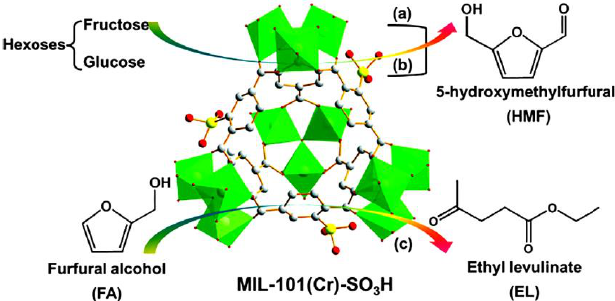
Figure 10. Transformations of ( a ) fructose and ( b ) glucose into HMF and ( c ) furfural alcohol into ethyl levulinate over SO 3 H-MIL-101(Cr). Reprinted with permission from reference [36]. Copyright 2016 Viley-VCH.